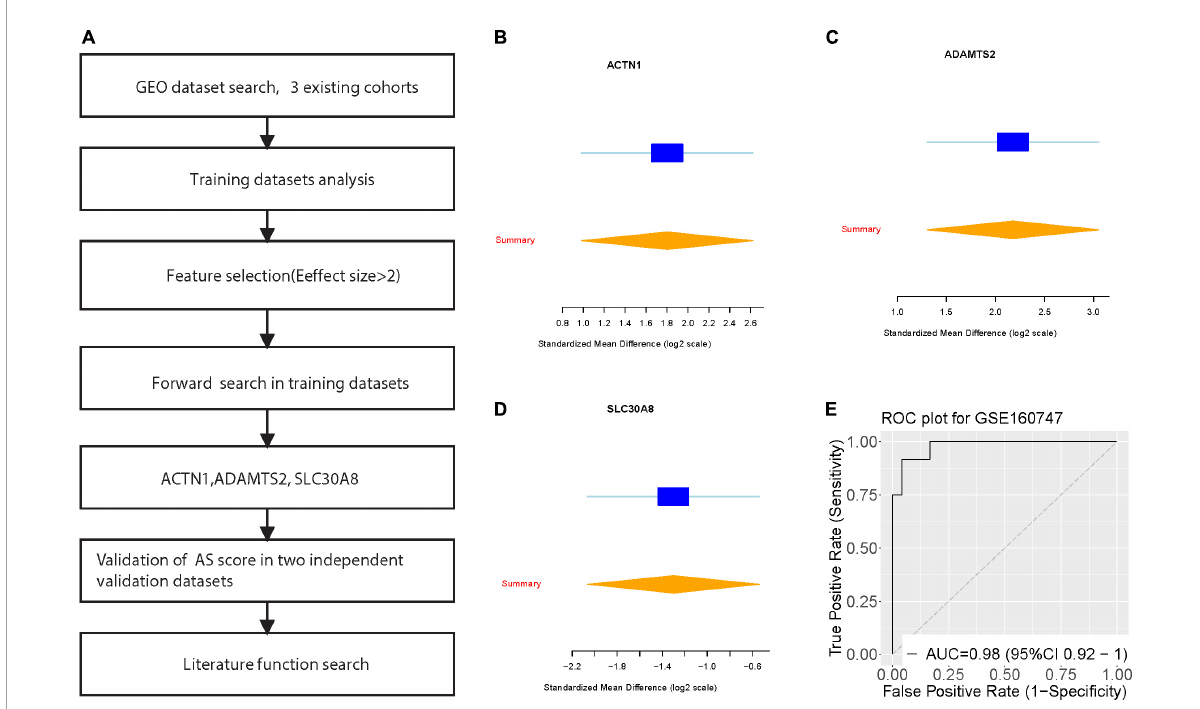
FIGURE1 Discovery of three differentially expressed genes in diagnosis of Angelman syndrome. (A) Multi-cohort analysis workflow for identifying and validating the three differentially expressed genes. (B–D) The up-regulated gene (ACTN1) and down-regulated genes (ADAMTS2, and SLC30A8) from the forward searches in GSE160747. The x axis represents standardized mean difference between AS and dengue control. (D,E) ROC curves of patients with AS vs. controls in GSE160747.